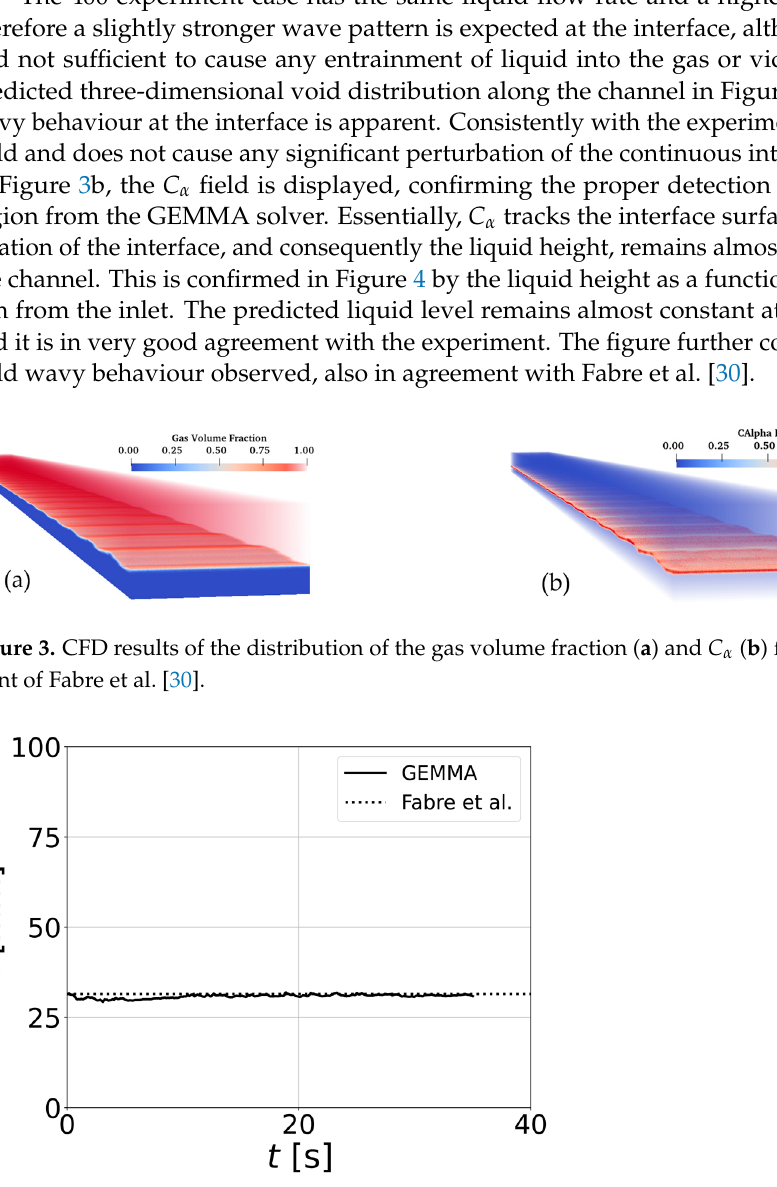
Figure 4. CFD prediction of the liquid height as a function of time for the 400 experiment of Fabre et al. [30].